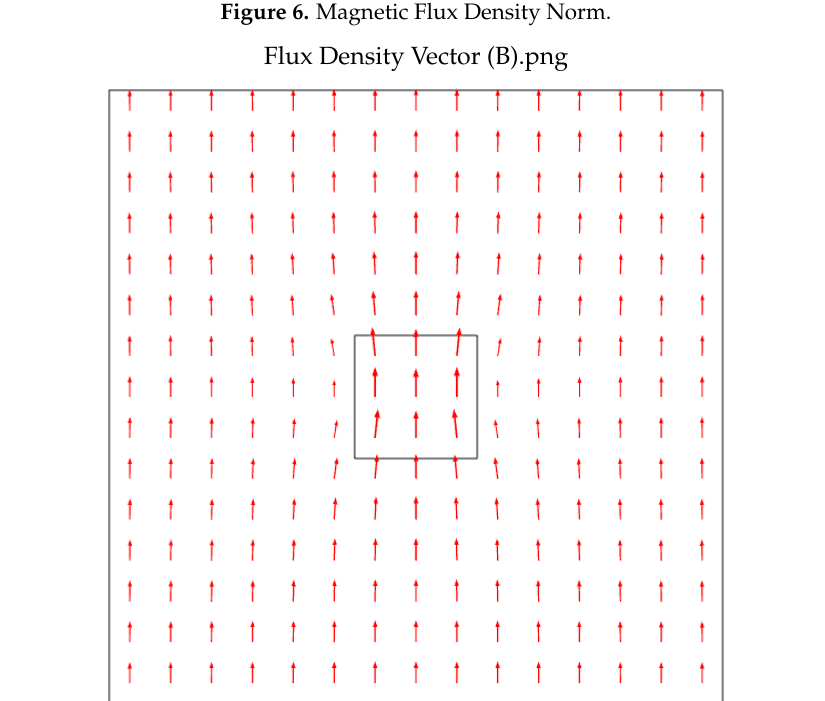
Figure 7. Magnetic Flux Density